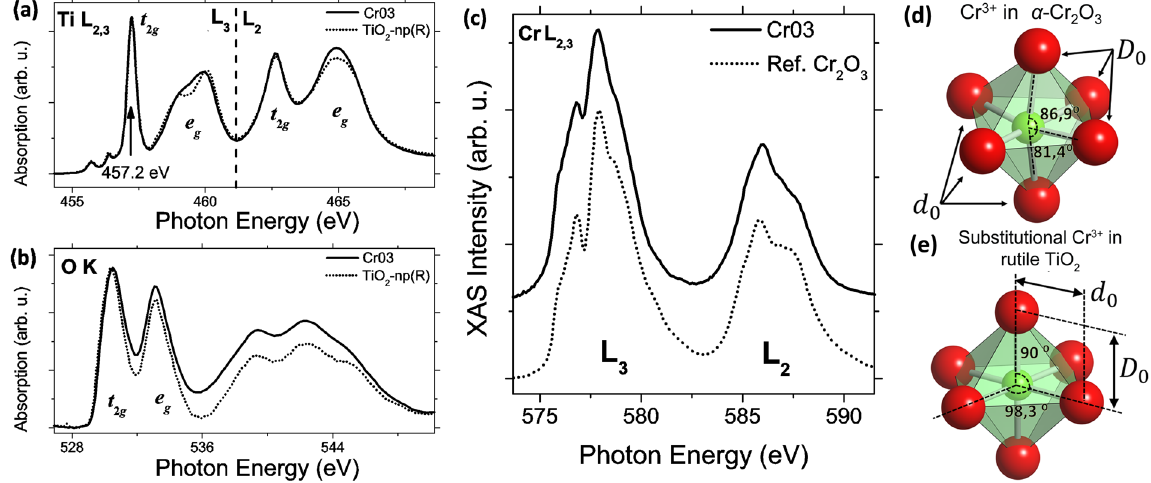
Figure 6. ( a ) XAS spectra from Ti-L 2,3 edge, ( b ) O-K edge and ( c ) Cr-L 2,3 edge. ( d ) CrO 6 octahedron from α - Cr 2 O 3 and ( e ) Cr Ti 1 − defect in rutile TiO 2